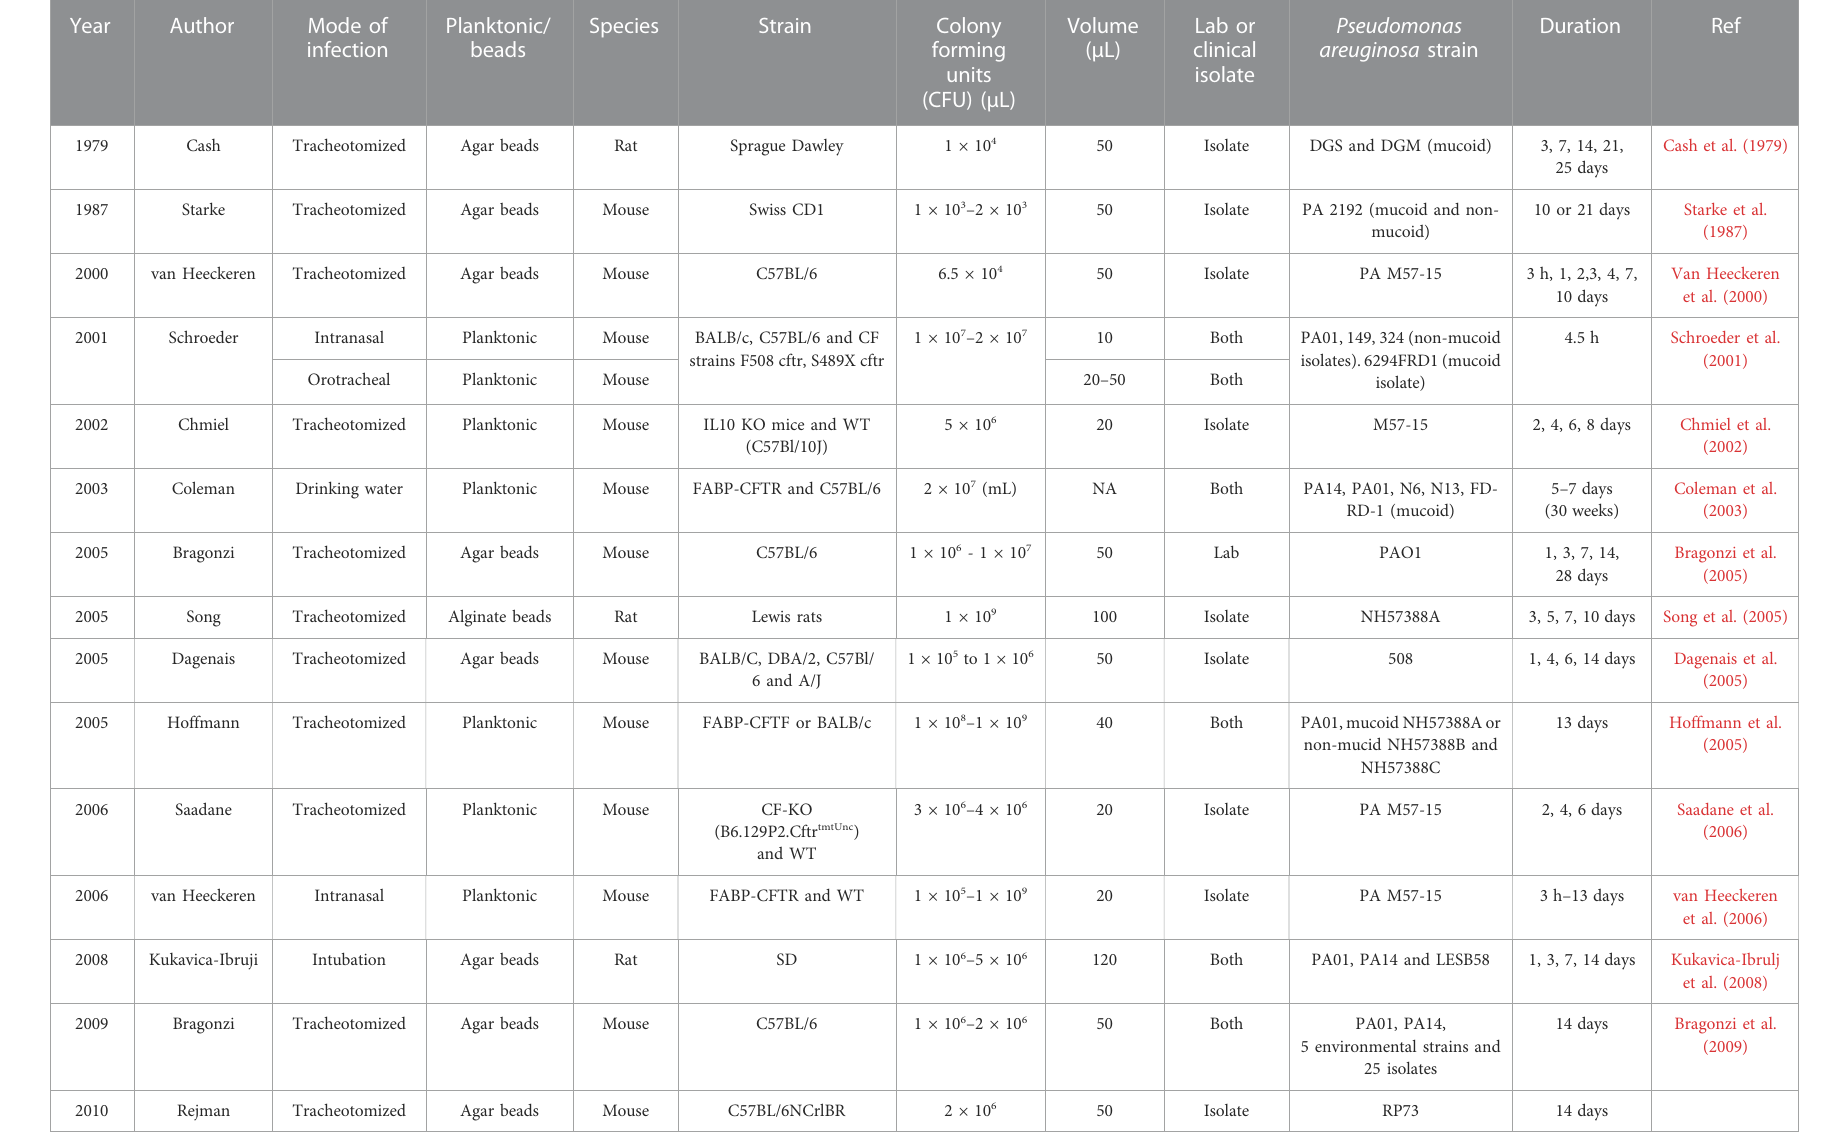
TABLE 1 Overview of Pseudomonas aeruginosa lung infection models. Note that a more comprehensive electronic fi lterable spreadsheet version is included as supplementary